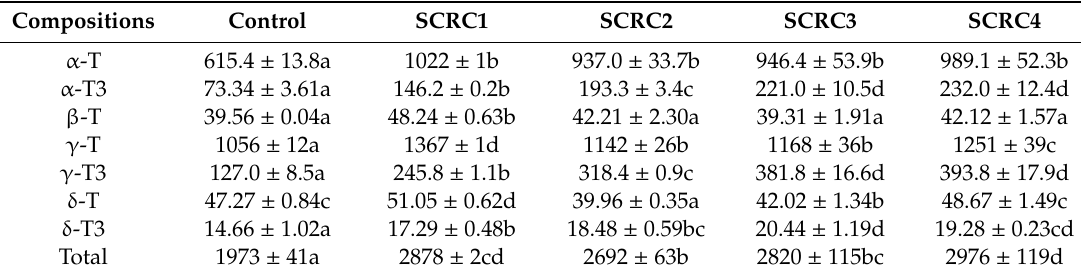
Table 5. Composition and content ( µ g / 100 g) of vitamin E in cakes.